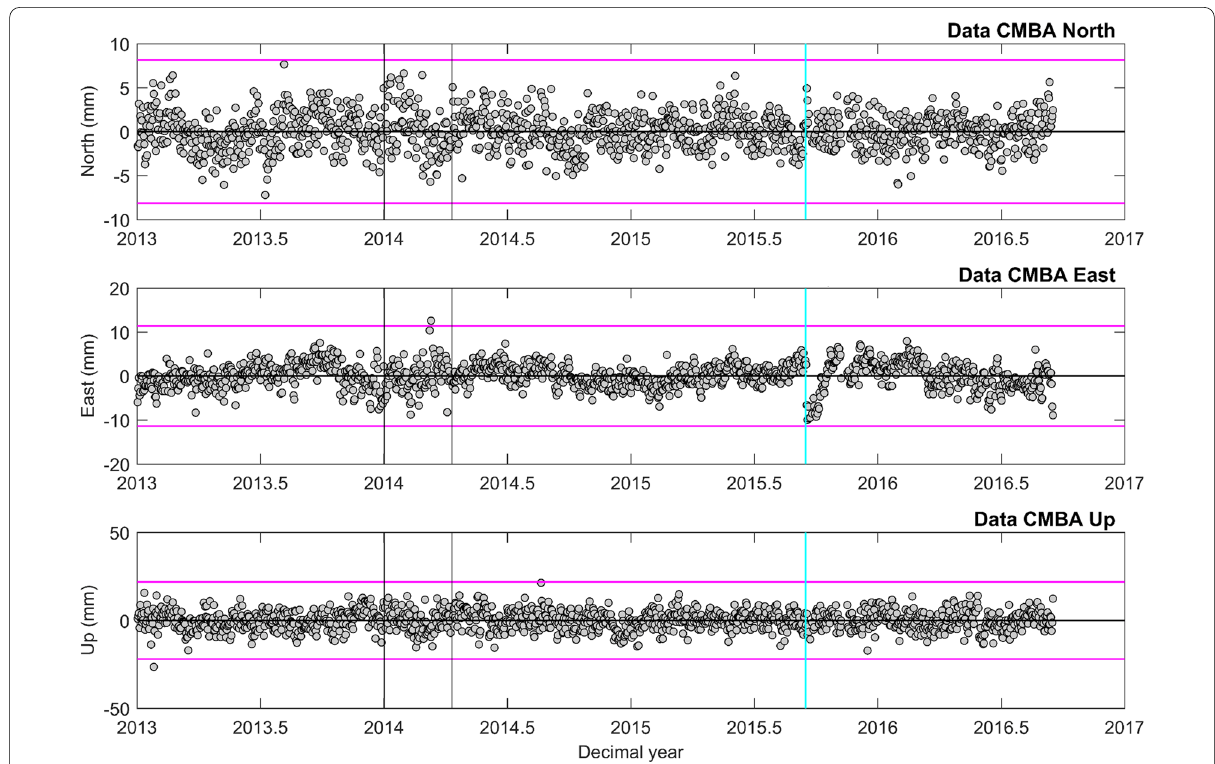
Fig. 5 Residual time series after removing signals of site